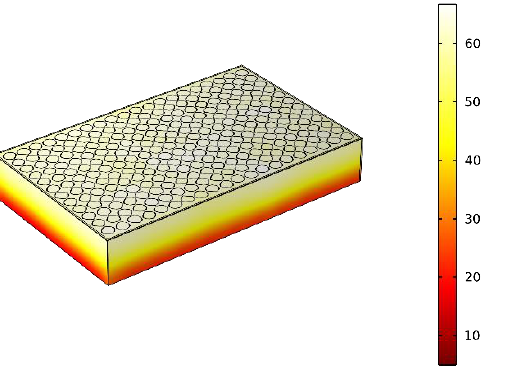
Figure 3. Temperature contours of the entire battery pack in plastic (acrylic) housing at 2C discharge rate while ambient temperature of 5 °C is considered.